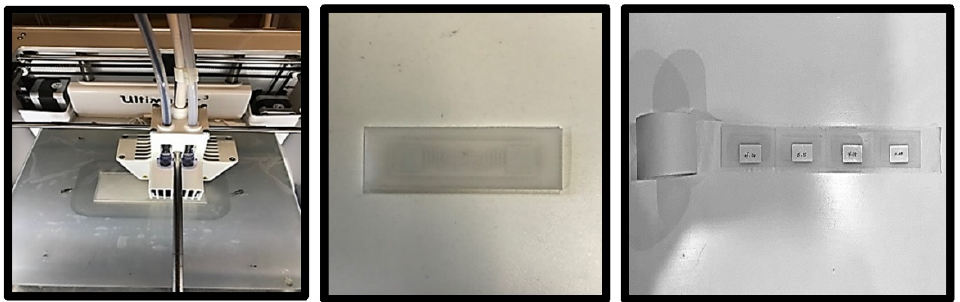
Figure 1. RFID sensor encapsulation using a 3D printer and arranging them into a sensor